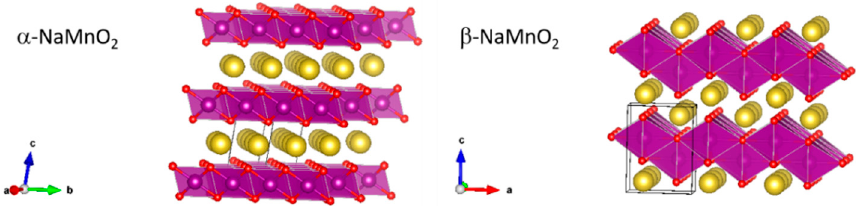
Figure 1. Representations of the structure of the two polymorphs of NaMnO 2 (red = oxygen atoms; purple = MnO 6 octahedra; yellow = sodium atoms).